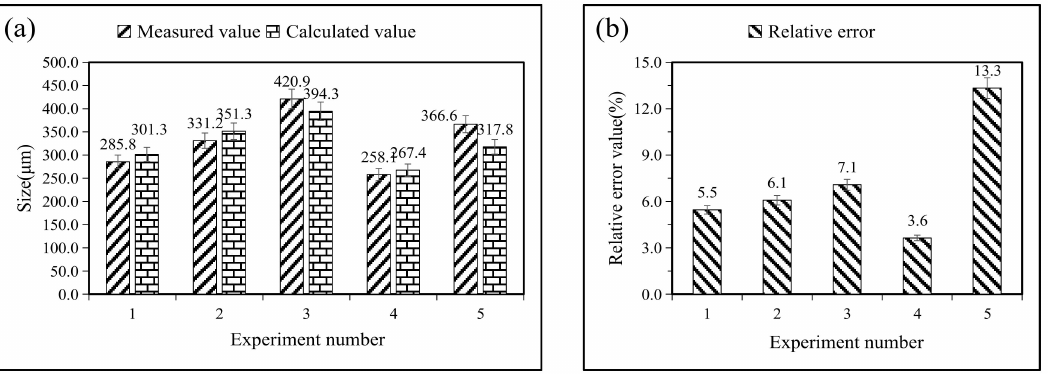
Figure 11. Error verification of Equation (7) (( a ). comparison of measureed value and calculated value; ( b ). corresponding relative